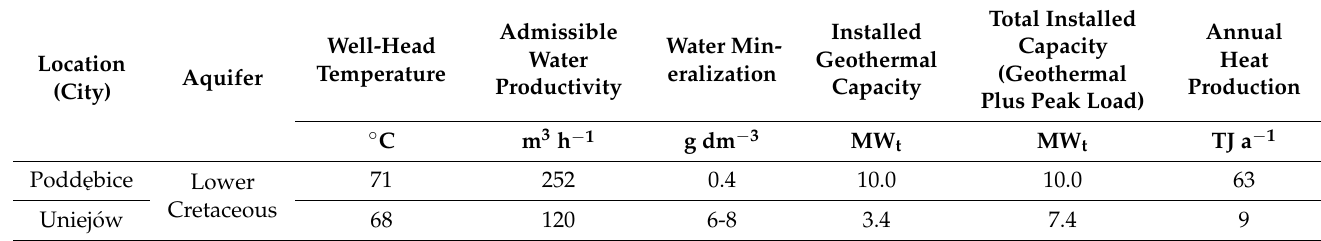
Table 1. The main operating parameters of the geothermal installations in Mogilno-Ł ó d´z Trough.